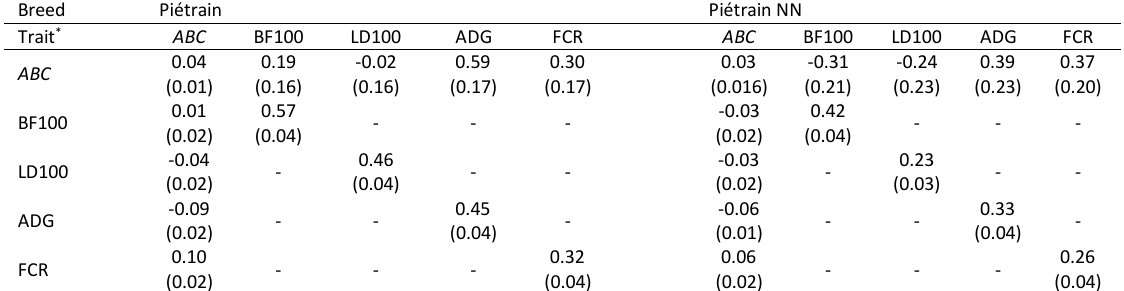
Table 5. Estimates of heritabilities (diagonal) and of genetic (above diagonal) and phenotypic (below diagonal) correlations among ABC and four commercial selection traits in Pie and Pie NN Breed Piétrain Piétrain